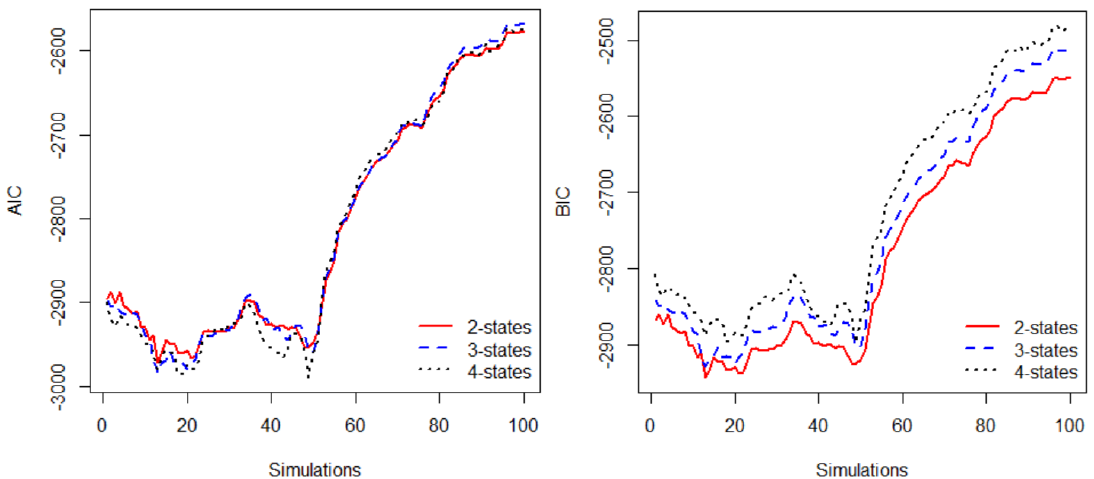
Figure 3. AIC ( left ) and BIC ( right ) for 100 parameter calibrations of HMM using Apple, AAPL, stock daily return